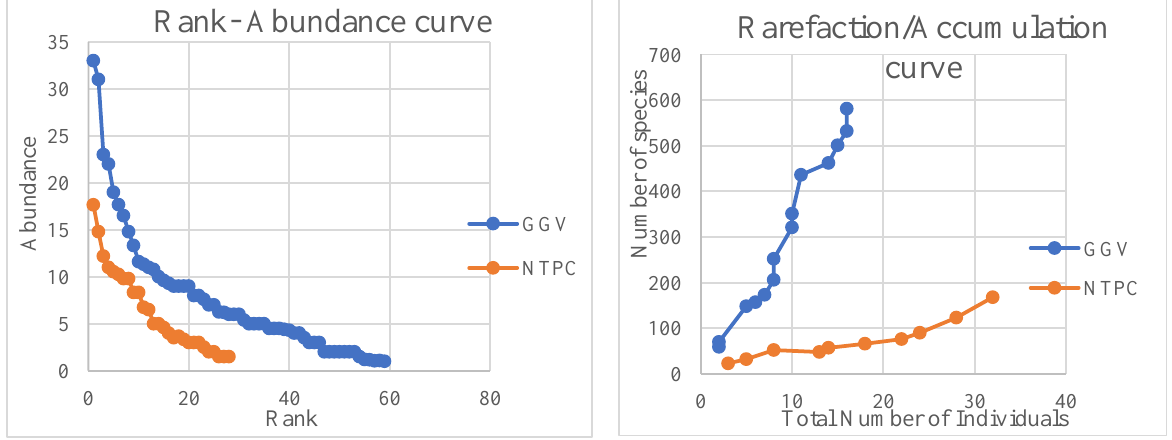
Figure 2. Rank – abundance curve and rarefaction curve of GGV(Site-I) and NTPC(Site-II). Figure 2. Rank–abundance curve and rarefaction curve of GGV(Site-I) and NTPC(Site-II). These trends of variation in species diversity can be explained by the analysis of soil from both places, shown in Table 3. Table 3. Properties of soil and heavy metal